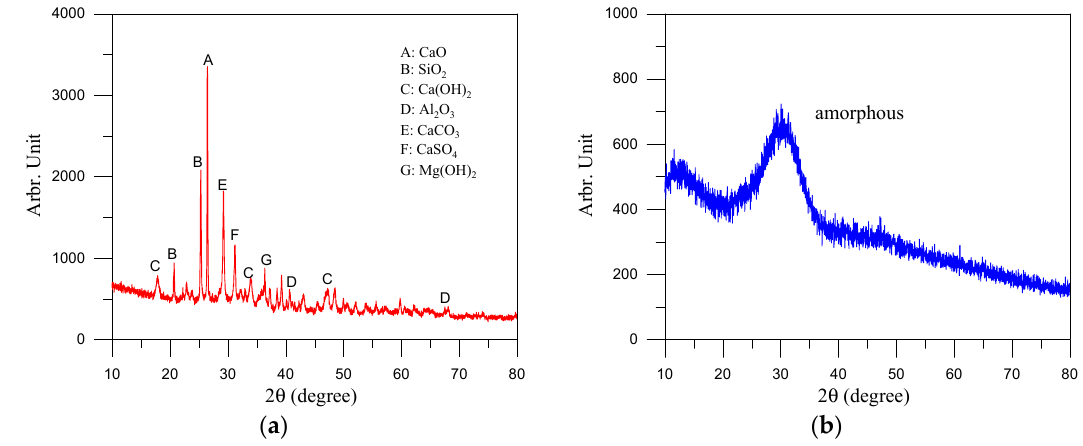
Figure 2. x-ray diffraction (XRD) pattern: ( a ) co-fired fly ash and ( b ) GGBS. Figure 2. x-ray di ff raction (XRD) pattern: ( a ) co-fired fly ash and ( b ) GGBS.